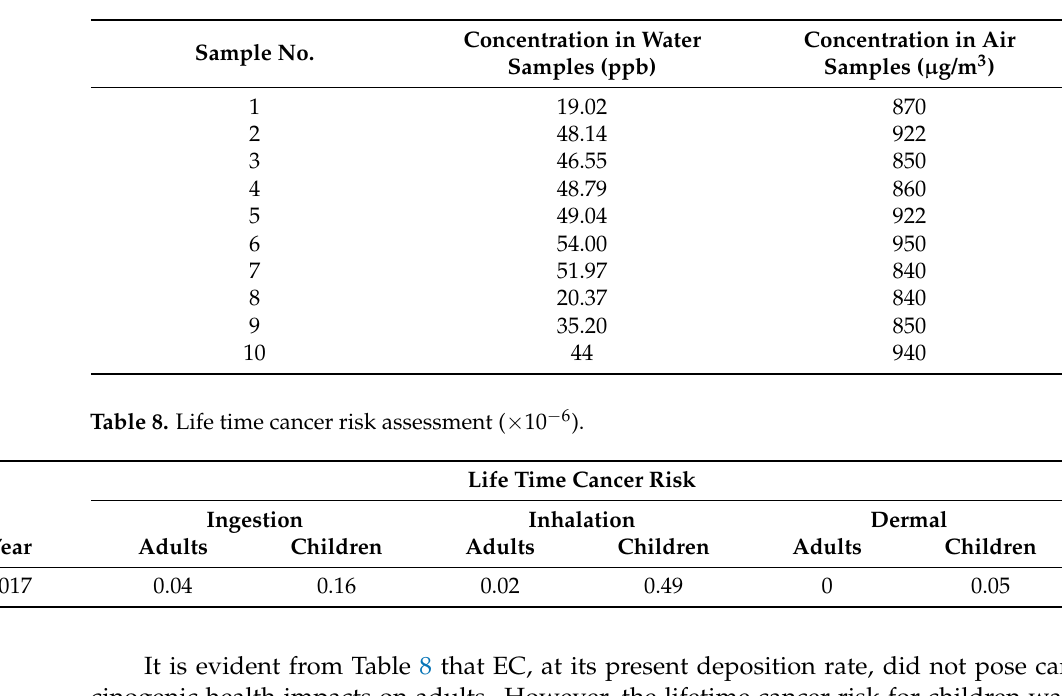
Table 7. Concentration of EC in different environmental media.